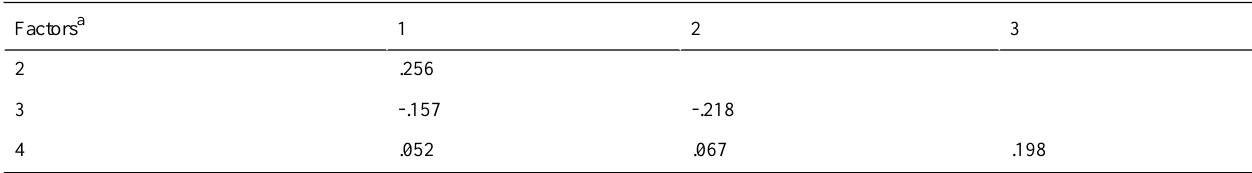
Table 5. Factor correlations of the principal component